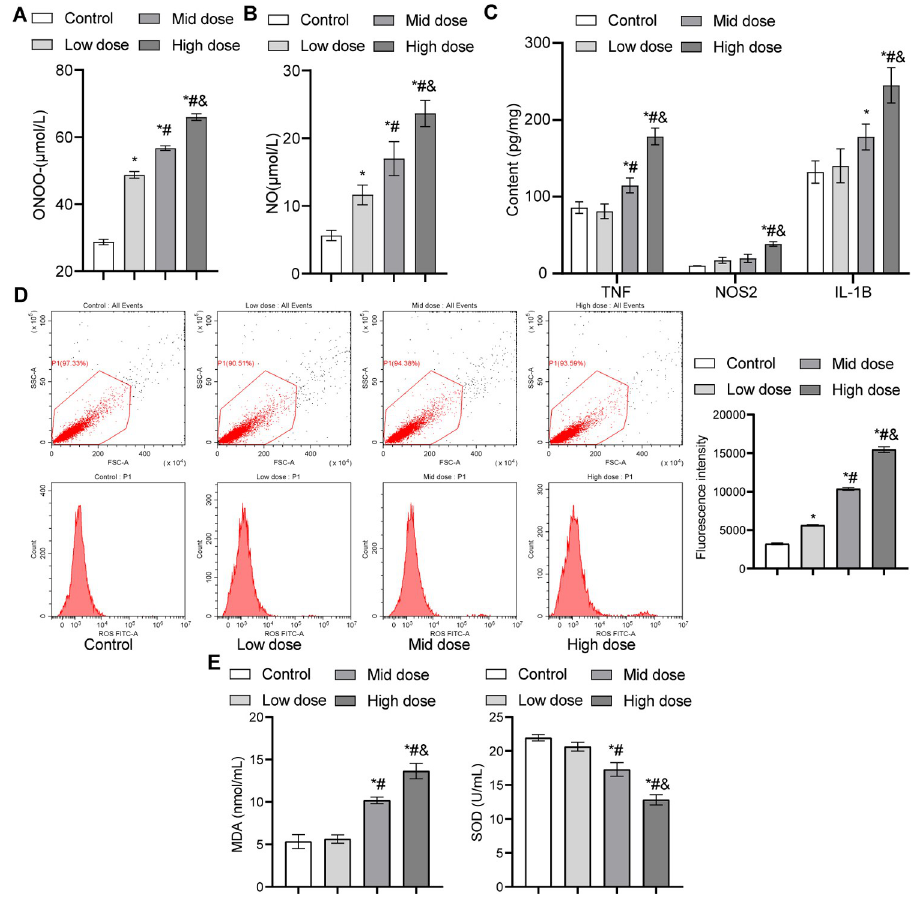
Fig 1. Exposure to sodium nitrite during pregnancy induces inflammation and oxidative stress. (A) The concentration of plasma peroxynitrite in pregnant rats as detected by ELISA, n = 12 rats/group. (B) Plasma NO levels in pregnant rats from different groups were detected by ELISA, n = 12 rats/group. (C) Effect of sodium nitrite exposure on blood inflammation in placenta tissues as detected by ELISA, n = 3 rats/group. (D) Flow cytometry was used to detect ROS in the fetal cerebral cortex, n = 3 rats/group. (E) Plasma MDA and SOD levels of fetal rats in different groups as detected by ELISA, n = 3 rats/group. � P < 0.05 vs . control group; # P < 0.05 vs . low dose group; & P < 0.05 vs . medium-dose group. MDA, malondialdehyde; NO, nitric oxide; ROS, reactive oxygen species; SOD, superoxide dismutase.